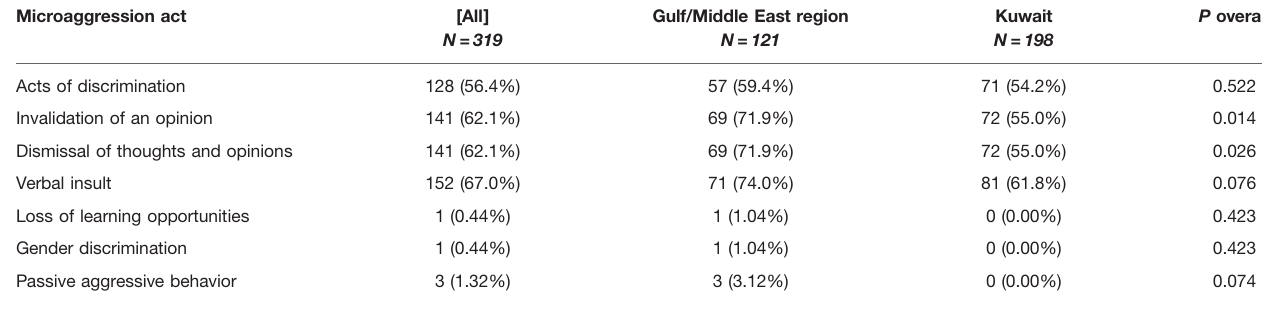
TABLE 3 | Incidence of microaggressions strati fi ed by